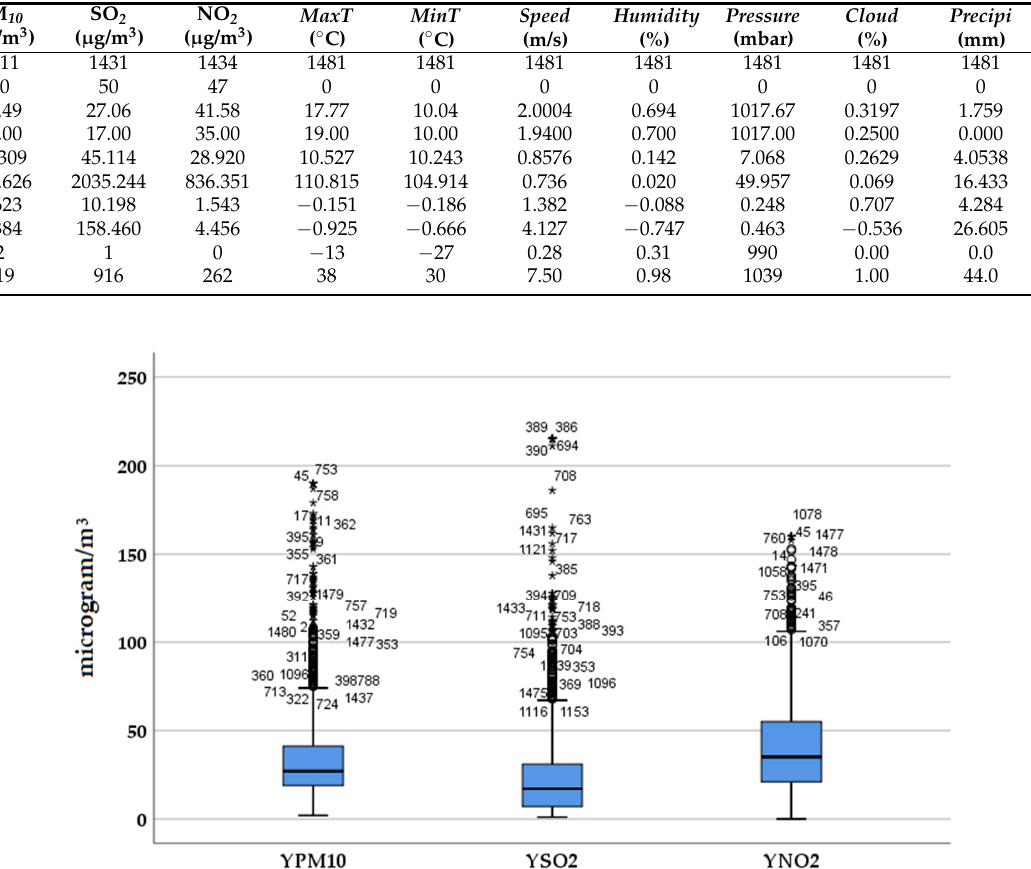
Figure 4. Box-plots of the used variables YPM 10, YSO 2, and YNO 2 for PM 10 , SO 2 , and NO 2 , respec- tively.